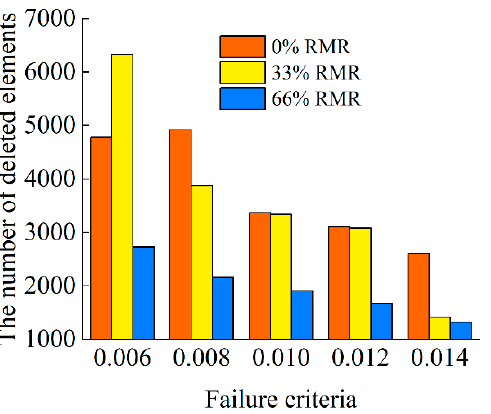
( d ) Figure 10. ( a ) Falling velocity versus effective value of velocity under different RMR. ( b ) Falling velocity versus effective value of acceleration under different RMR. ( c ) Falling velocity versus mean value of velocity under different RMR. ( d ) Falling velocity versus mean value of acceleration under different RMR. 3.1.3. Strength Due to the different geological conditions, the strength of coal in different regions will be different, resulting in different degrees of coal fragmentation. Therefore, based on the model in the previous section, this section adjusts the strength of coal to five different strengths. By adjusting the failure criteria in the keyword MAT_ADD_EROSION to control the strength of the coal material, a variety of strength tests were carried out for the RMR of 0%, 33%, and 66%. The failure criteria were set to 0.006, 0.008, 0.01, 0.012, and 0.014, re-